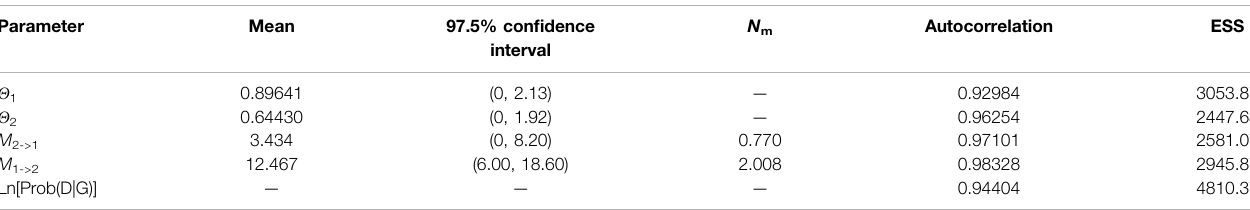
TABLE 6 | Summarized results of the MIGRATE-n analyses.